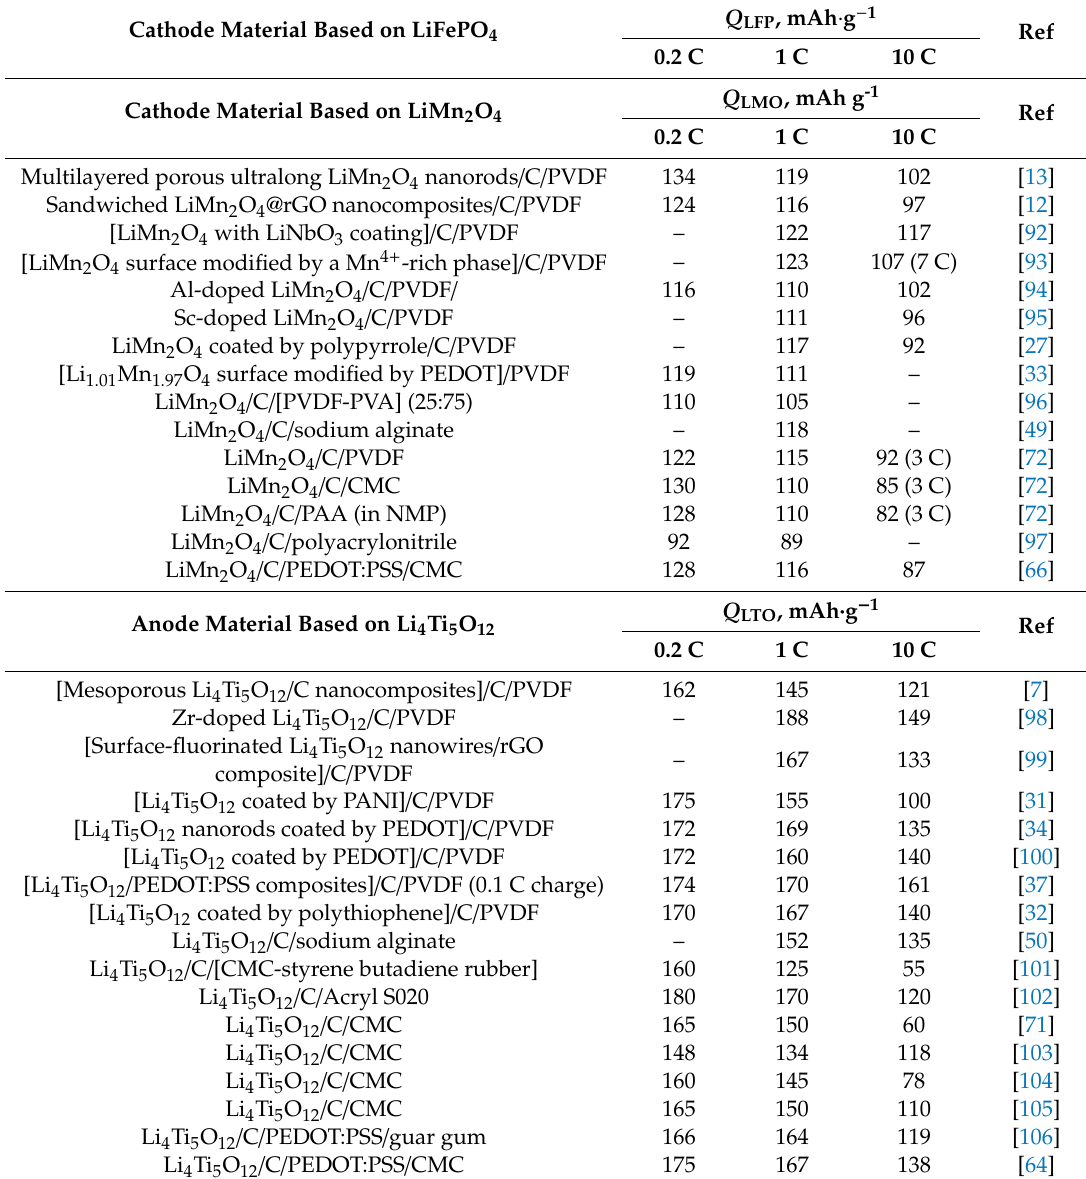
Cathode Material Based on LiFePO